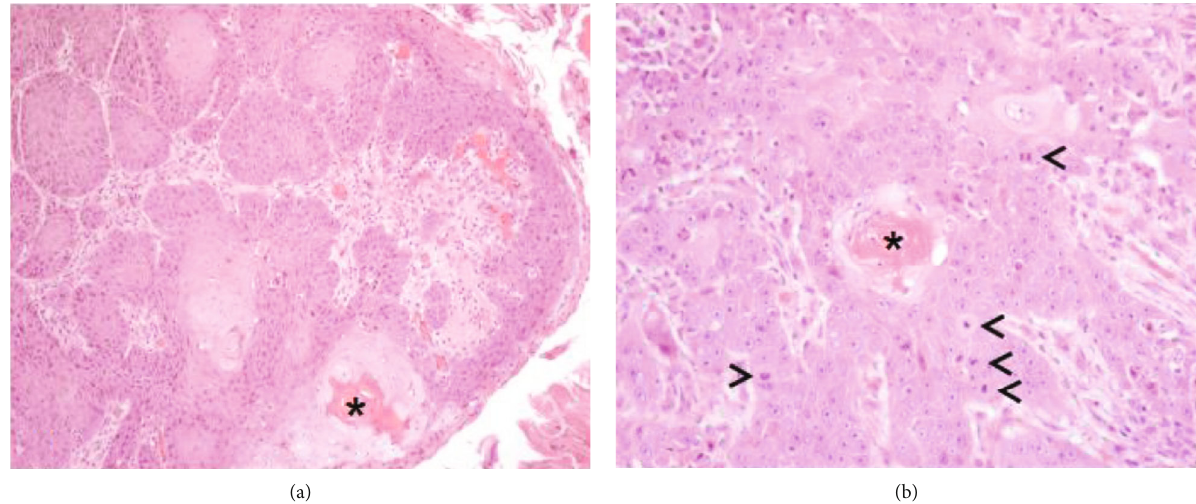
Figure 2: Suckling piglet. Oral lesion. Histopathology. Cords and islands of neoplastic cells almost entirely in fi ltrate the lamina propria of the oral mucosa (a). Inside the proliferation, neoplastic cells undergo keratinization and tend to arrange as concentric layers, thus forming a horn pearl draft (black asterisk). At this magni fi cation, prominent nucleoli are also evident, as well as several mitotic fi gures (black arrowheads; (b)). H&E, original objective 10x (a) and 20x (b).